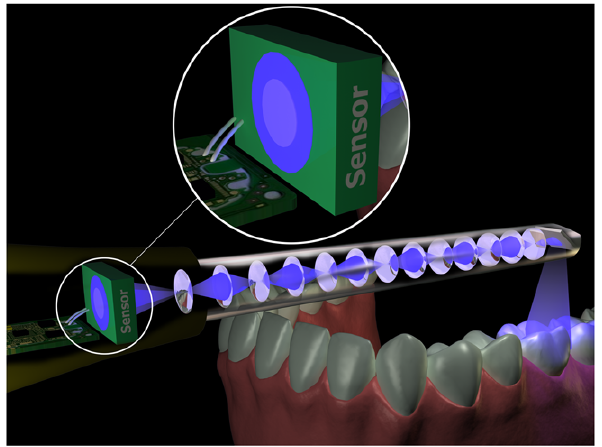
Figure 5. The measurements were made between the centers of the high-precision cylinders. Three 3D CAD models of the cylinders in the model were imported and registered with each of the scanned equivalents. The distance between the centre-lines was measured in the software using a linear measurement tool. The angular deflection of the cylinders was measured with an angular measurement tool, using the cylinder at the location of the lower right molar as the baseline.